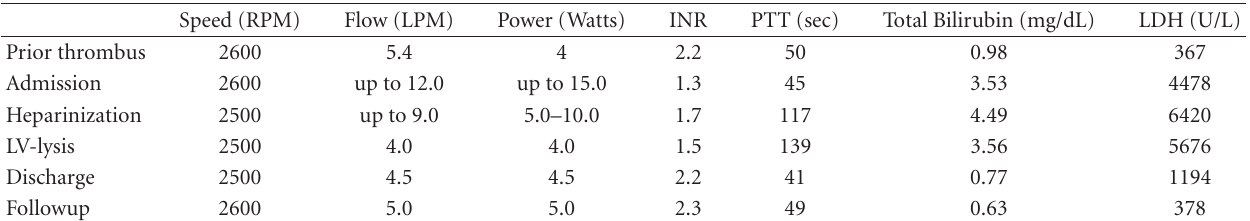
Figure 1: Imaging of fluoroscopy-guided thrombolysis. The 5-French pigtail catheter is placed directly in front of the LVAD inflow cannula (white arrows): (a) RAO exposure and (b) LAO exposure. Table 1: HVAD parameters and laboratory data over the time (anticoagulation and